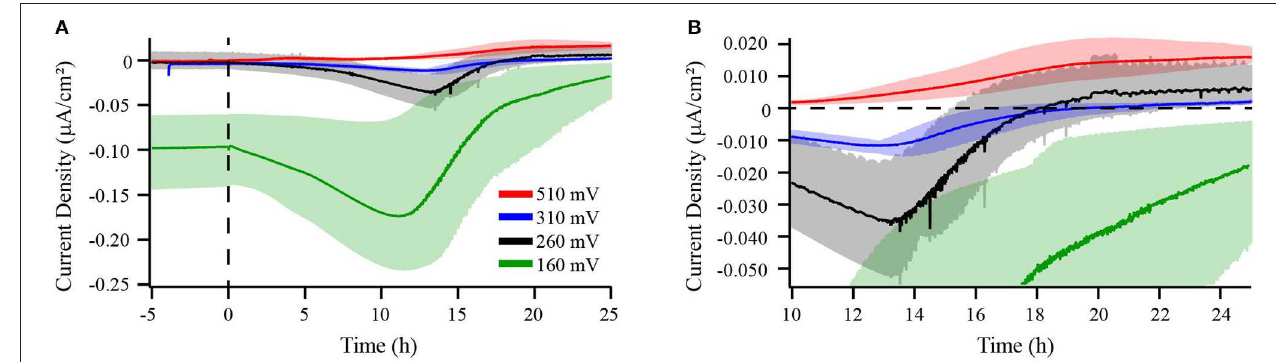
FIGURE 1 | Chronoamperometry of M. atlanticus biofilms grown at 510 (red), 310 (blue), 260 (black), and 160 (green) mV vs. SHE. Current produced by both abiotic and biotic BES is shown in panel (A) . Panel (B) shows a zoomed-in view of current production where 0 µ A/cm 2 is indicated by a dashed line. Bioelectrochemical systems (BES) equipped with carbon cloth working and counter electrodes were inoculated with wild type (WT) M. atlanticus and current was monitored over time. Solid lines represent an average of triplicate measurements and shaded areas represent the maximum and minimum values